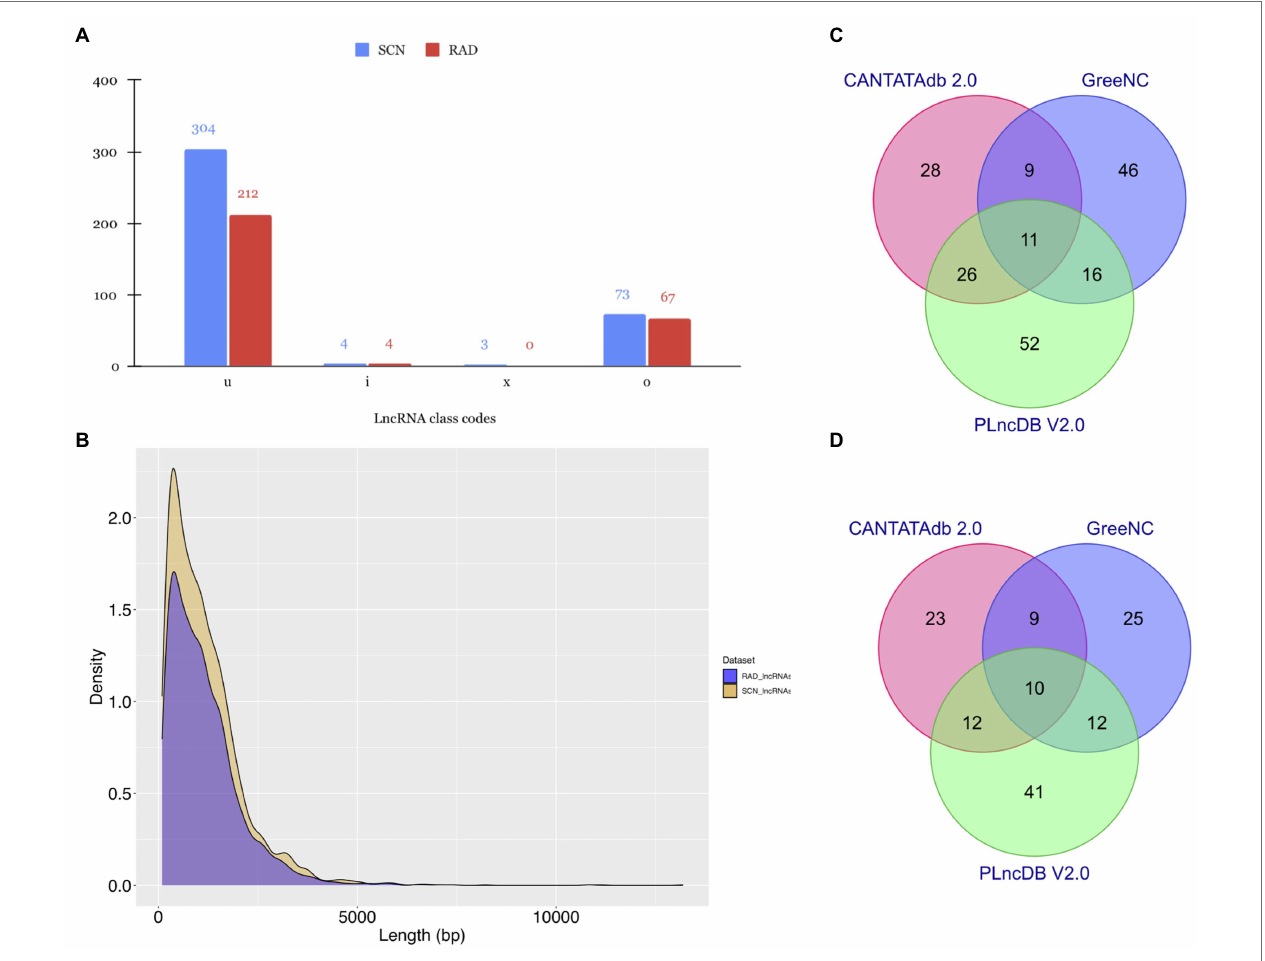
FIGURE 2 | Characteristic features of lncRNAs identified in SCN data set and RAD. (A) Subdivision of lncRNAs according to the class codes (“u,” “x,” “i,” “o,” and “e”) determined by StringTie. (B) Length distribution of lncRNAs. Venn diagrams depicting the BLAST results of lncRNAs in (C) SCN data set and (D) RAD against CANTATAdb 2.0, GreeNC, and PLncDB v.2.0